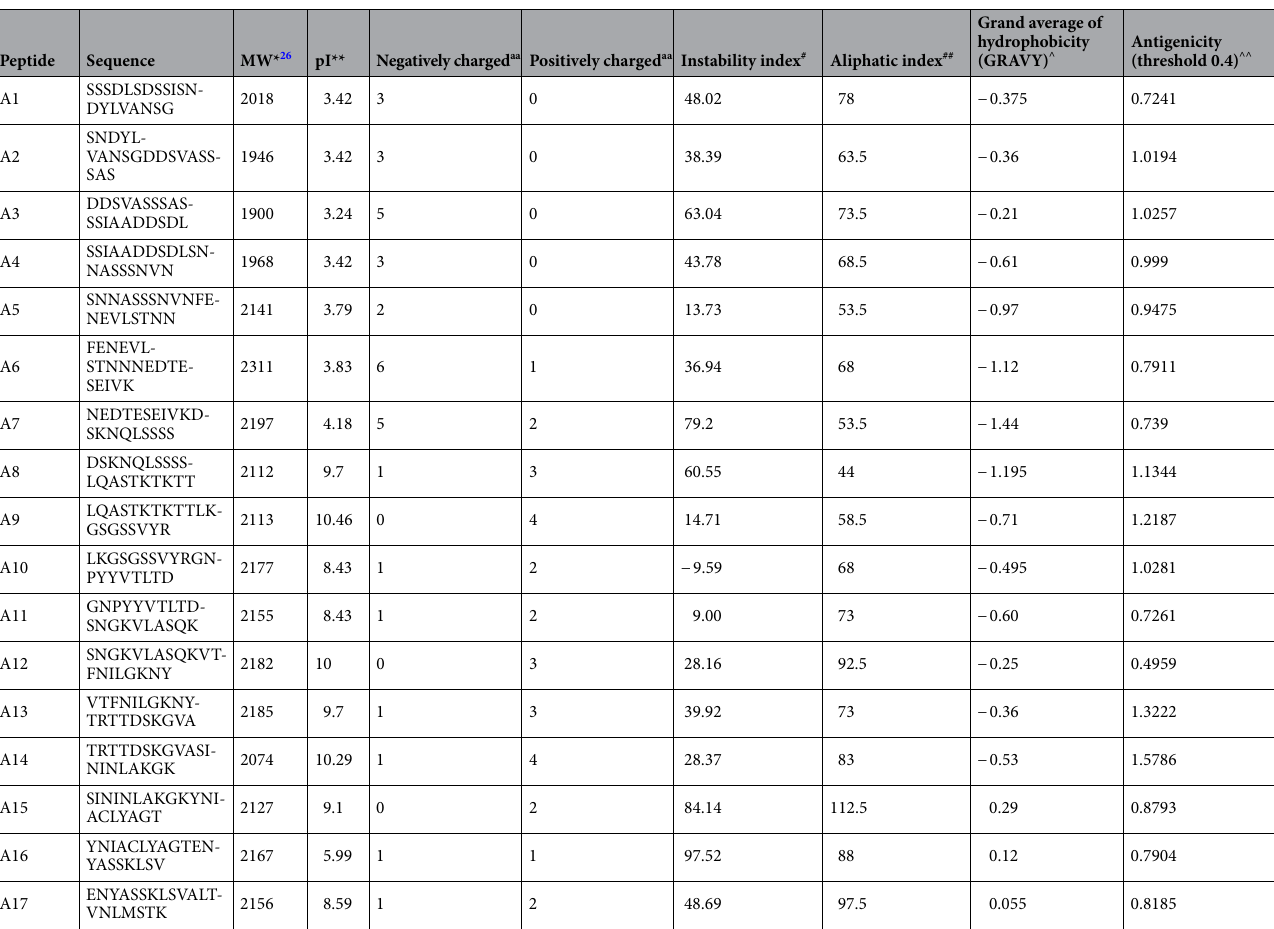
Table 1. Summary of predicted physiochemical properties of peptides 24,25 . *MW (molecular weight in g/mol). **pI (isoelectric point). # Instability index (value of instability index smaller than 40 is predicted as stable, a value above 40 predicts that the peptide may be unstable). ## Aliphatic index (larger values represent increase of thermostability of the peptide). ^ GRAVY (positive GRAVY values indicate hydrophobic nature of peptide and negative values indicate hydrophilic nature). ^^ Antigenicity index (values represent peptide